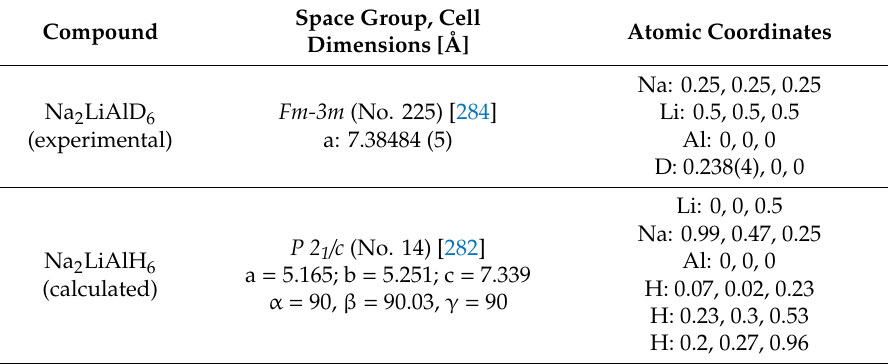
Table 14. Crystallographic data of Li-Na mixed alanates.